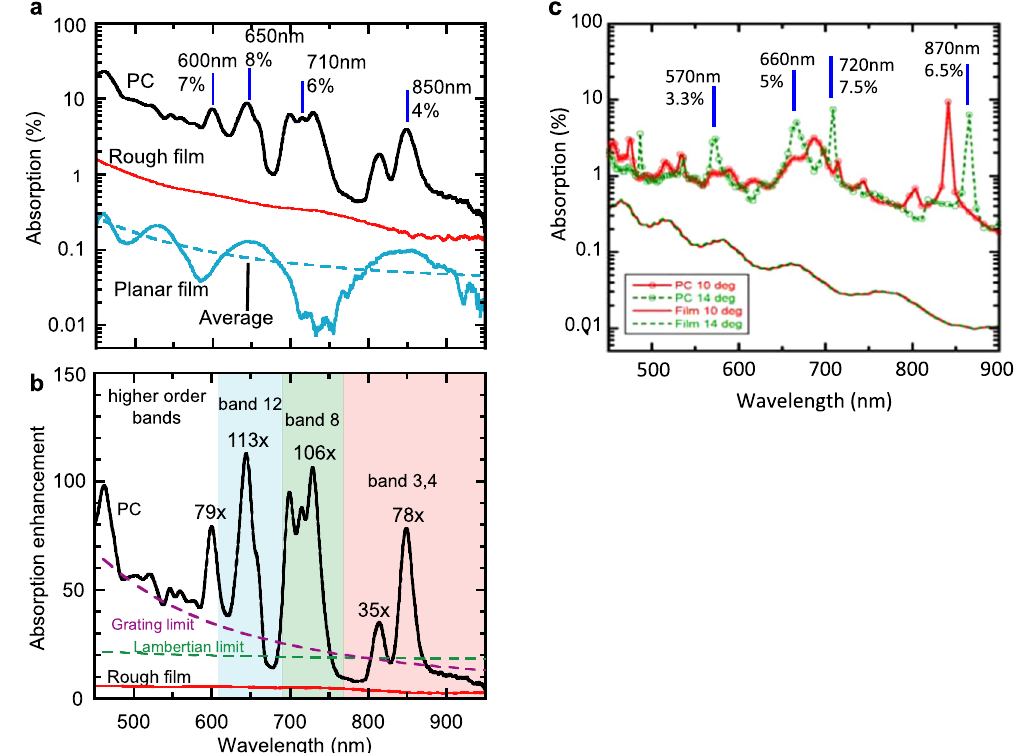
Figure 3. Broadband absorption enhancement in a TiO 2 photonic crystal. ( a ) Absorption spectrum for PC (black), and reference films R2 (red) and R1 (blue). ( b ) Absorption Enhancement for PC (black) and R2 (red) relative to R1. Also shown are theoretical limits for absorption enhancement in an ergodic system (Lambertian Limit), and in the diffraction grating on absorbing layer scheme. ( c ) An FDTD calculation of the photonic crystal absorption is shown for the wavelength range from 450–900 nm for incident angles of 10° and 14°. Absorption peaks are identified with a blue